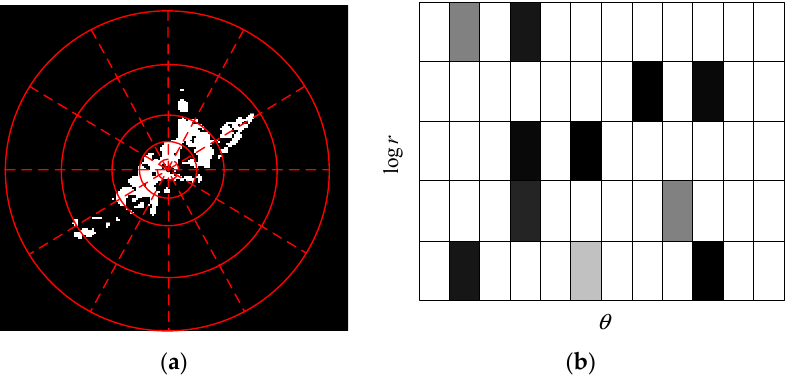
Figure 4. The original shape context descriptor. ( a ) The division of sampling points; ( b ) The histogram of sampling points.